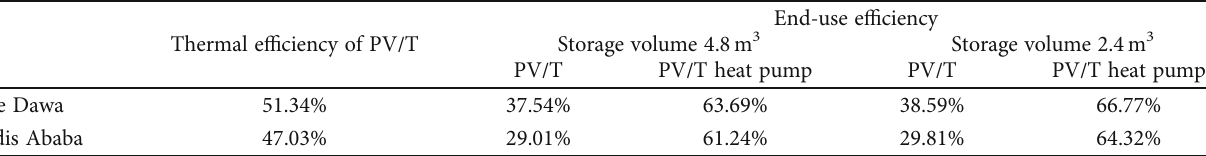
Figure 5: Comparison of performance of hybrid PV/T heat pump system in Dire Dawa and Addis Abba under constant hot water supply conditions during o ffi ce hours. Table 3: Annual hot water end-use e ffi cacy of Dire Dawa and Addis Ababa.